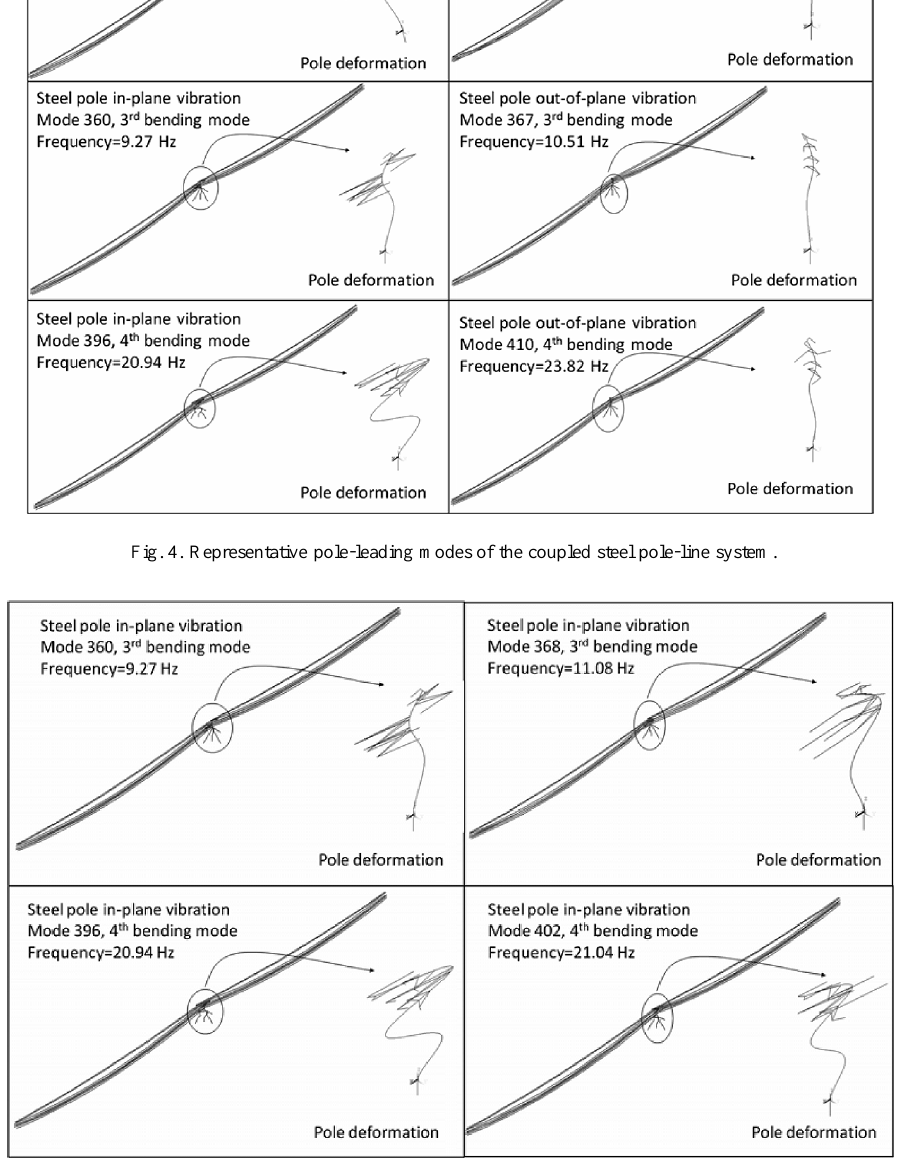
Fig. 5. Different coupled modes for steel pole